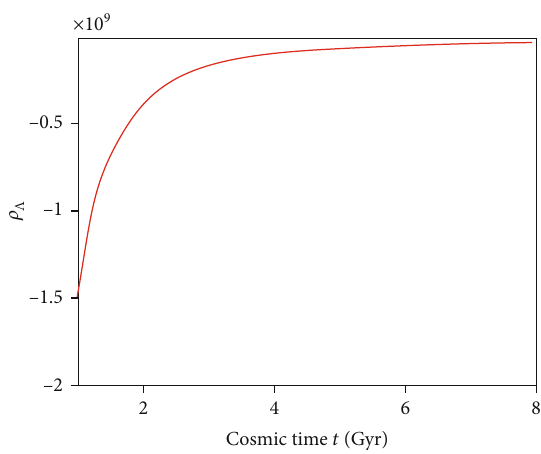
Figure 1: The plot of total density parameter ð Ω Þ versus cosmic time t for constants l = 1 : 5 , n = 2 , k = 0 : 5 , and m